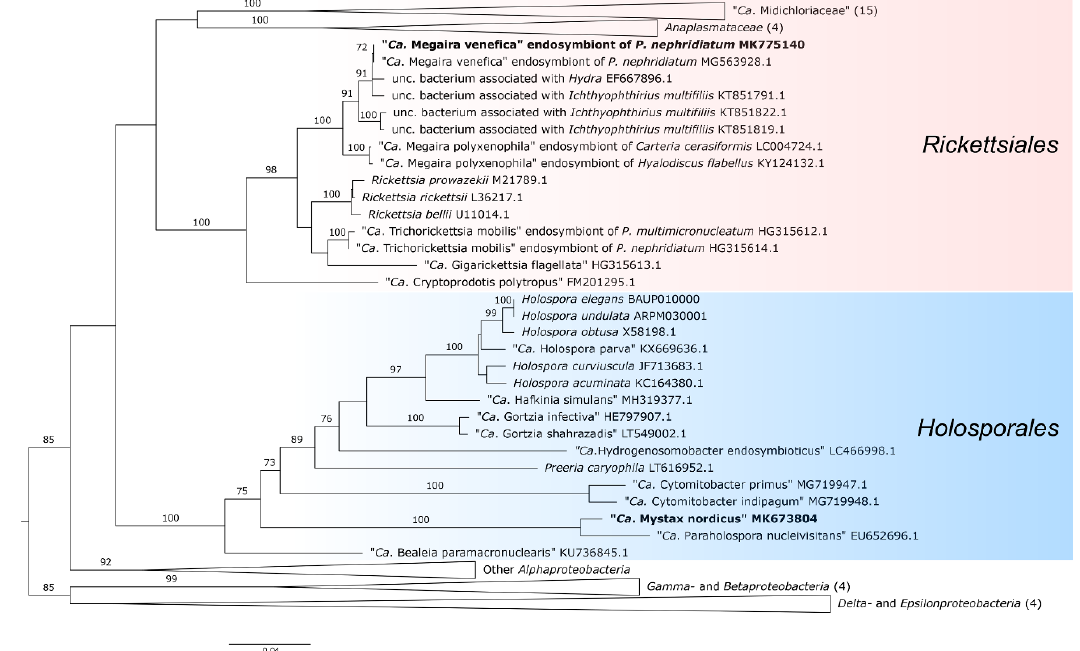
Figure 6. Maximum likelihood phylogenetic tree of 63 sequences inferred on 1399 16S rRNA gene nucleotide positions with the GTR+I+G substitution model. Reported in bold are sequences characterized in this study. Numbers associated with each node correspond to maximum likelihood bootstrap values (values below 70% are omitted); numbers in brackets indicate the number of sequences representing that clade. The bar stands for an estimated sequence divergence of 4%.